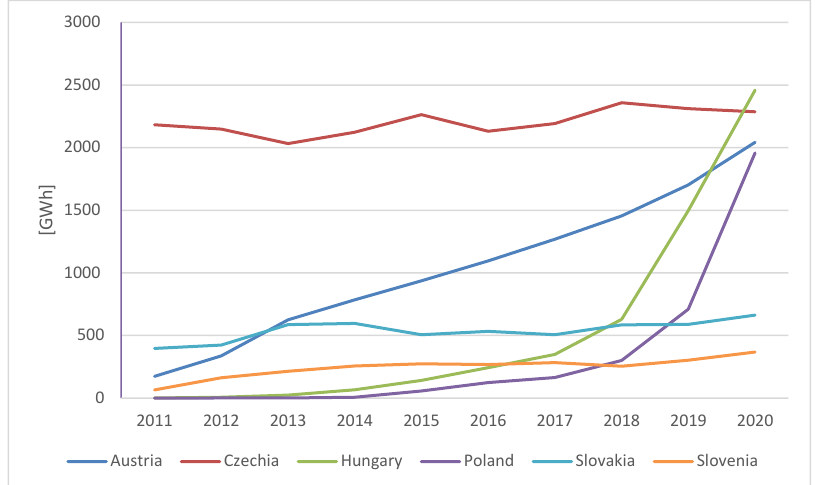
Figure 2. Electricity generation photovoltaics (PV) in Central European countries—without Germany